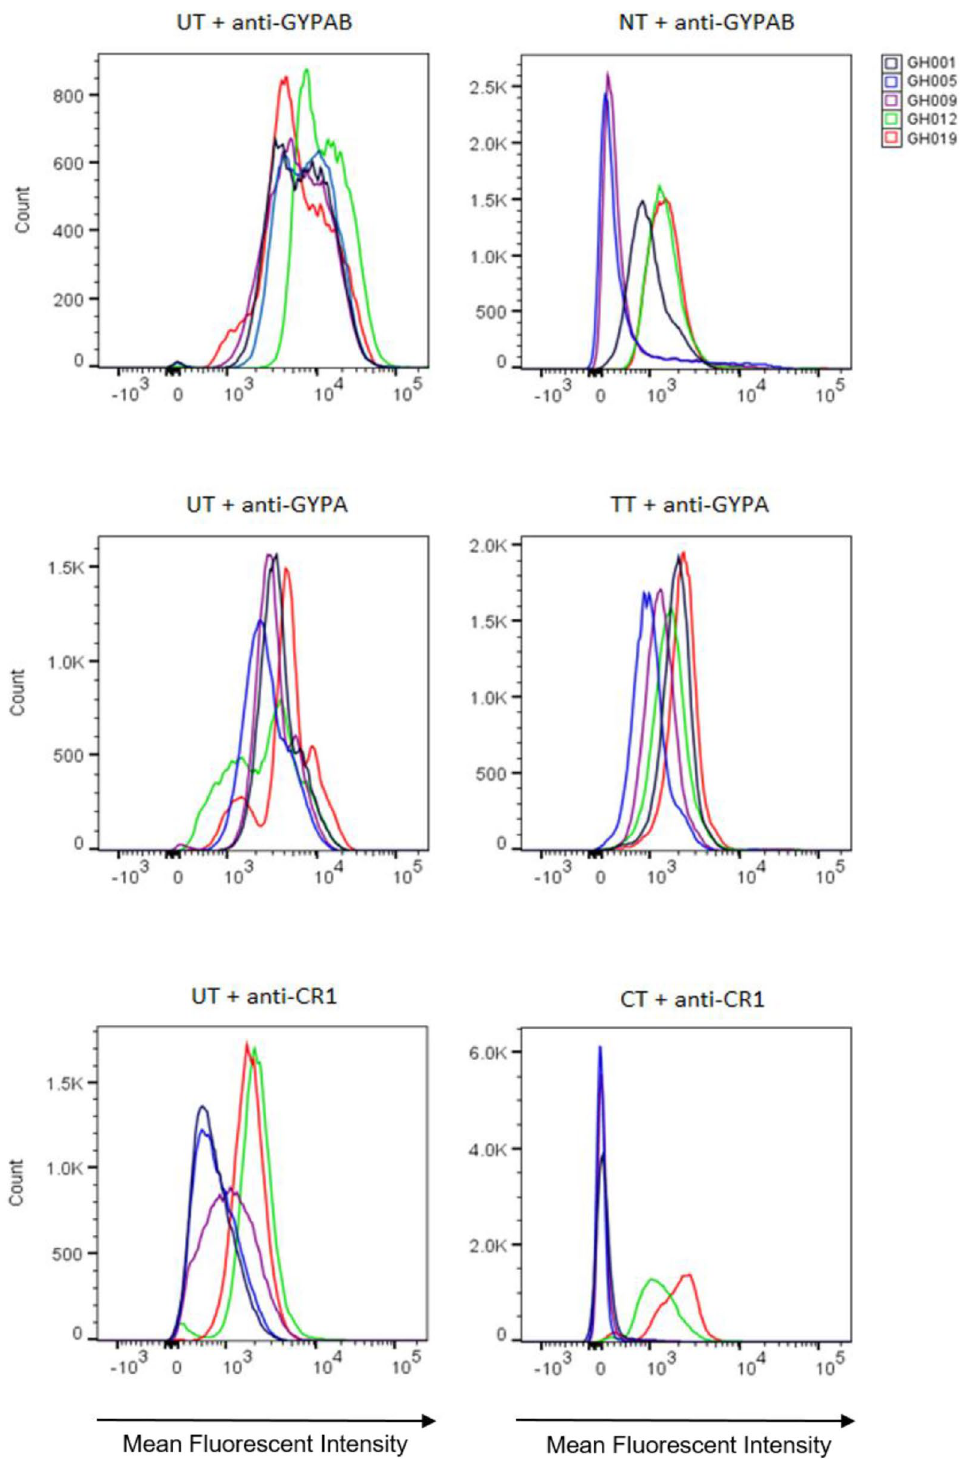
Figure 2. Efficacy of enzyme treatment of erythrocytes from different donors. Histogram plots showing the fluorescent intensity associated with antibodies against specific erythrocyte receptors prior to (left panel), and after (right panel) treatment with different enzymes ( NT neuraminidase treatment, TT trypsin treatment, CT chymotrypsin treatment). Target erythrocytes from five different donors were co-incubated for an hour with mouse anti-human GYPAB (top panel), GYPA (middle panel) or CR1 (bottom panel), then washed twice and incubated with goat anti-mouse-PE conjugated antibodies. The data was collected with a BD LSR Fortessa X-20 flow cytometer and graphs plotted using FlowJo